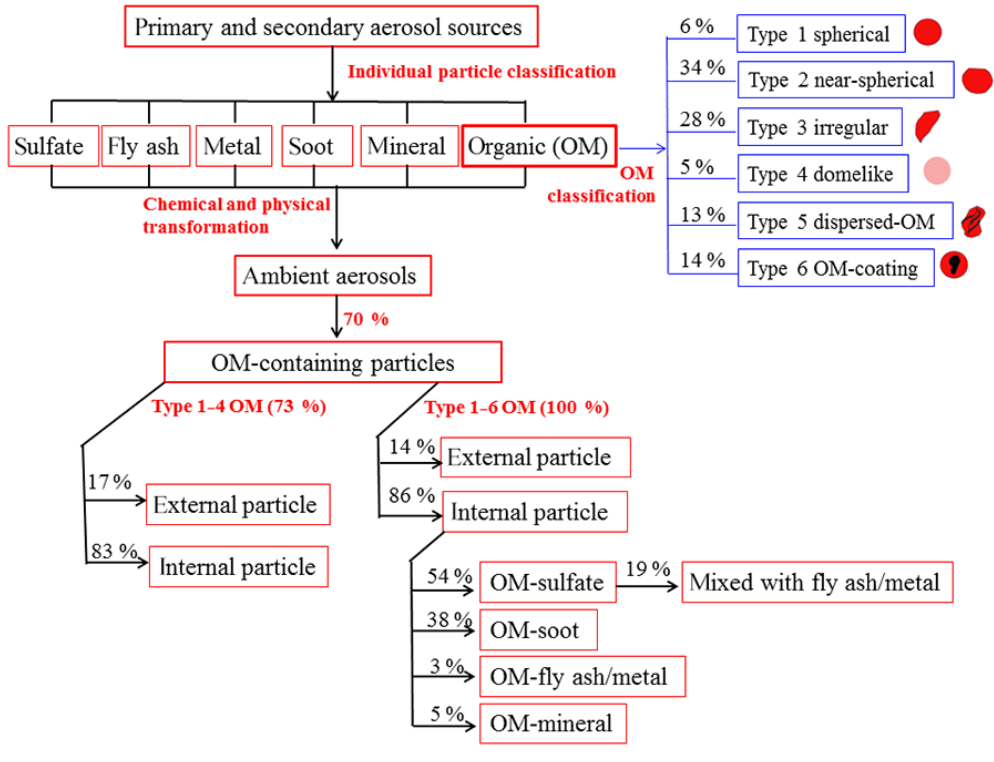
Figure 2. Flowchart of individual aerosol particles classification in L & M haze episodes in NCP based on TEM/EDX. A total of 5090 individual particles were analyzed using TEM/EDX.